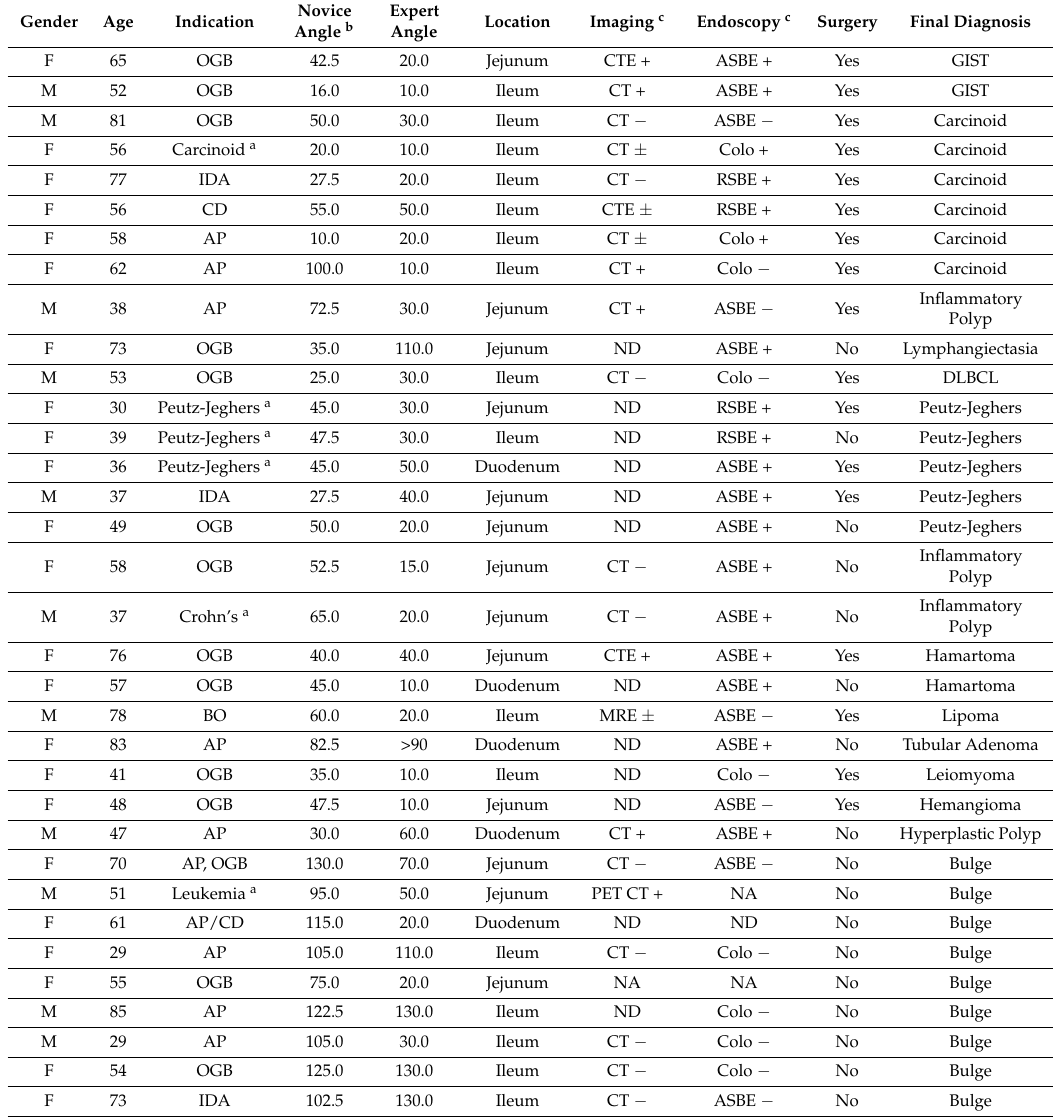
Table 1. Patient